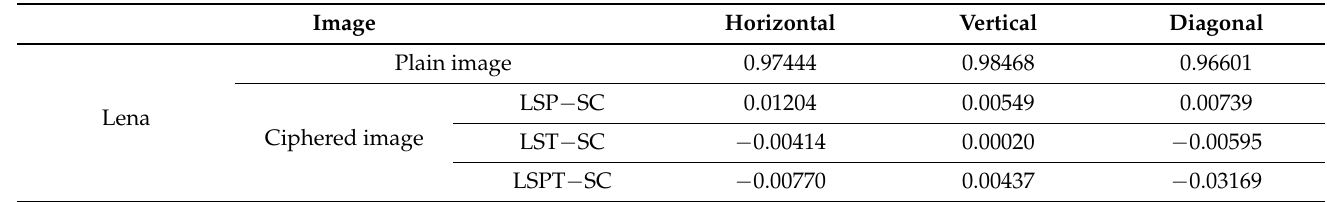
Table 11. Correlation coefficients of two adjacent pixels in the plain and ciphered images. Image Horizontal